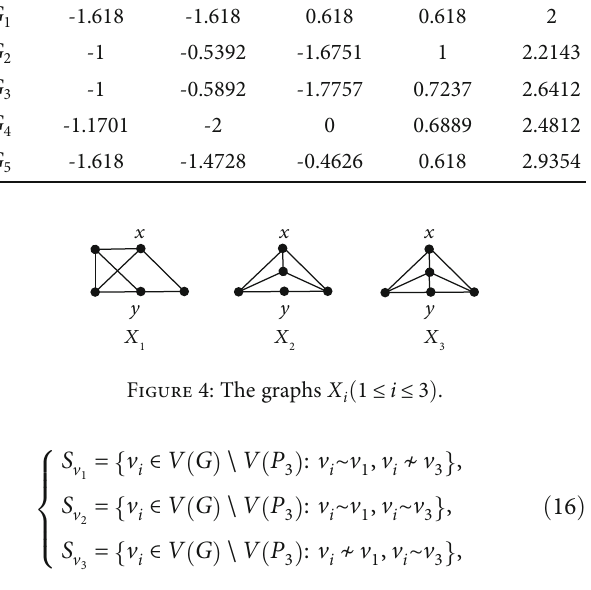
Figure 3: The graphs G